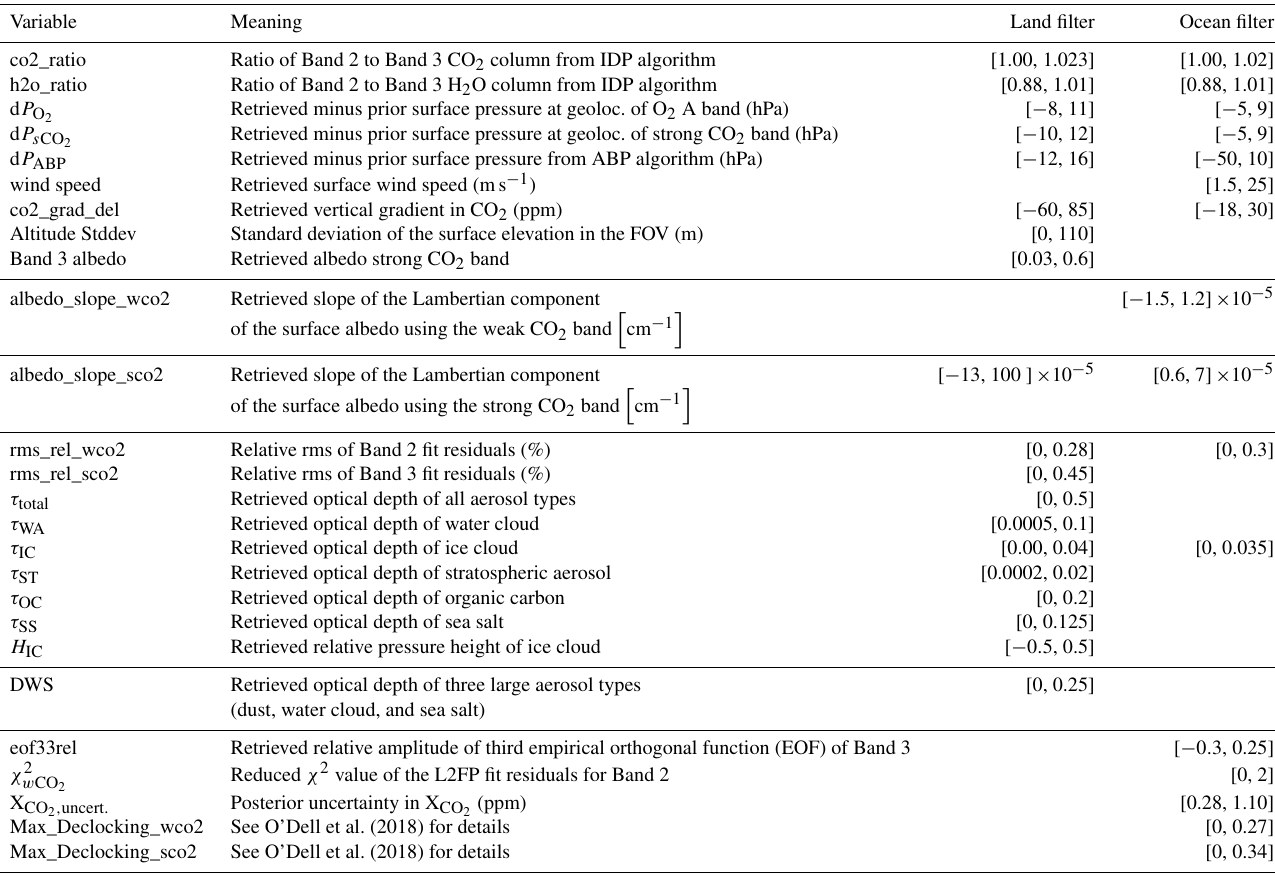
quality flag definition in v9. 2